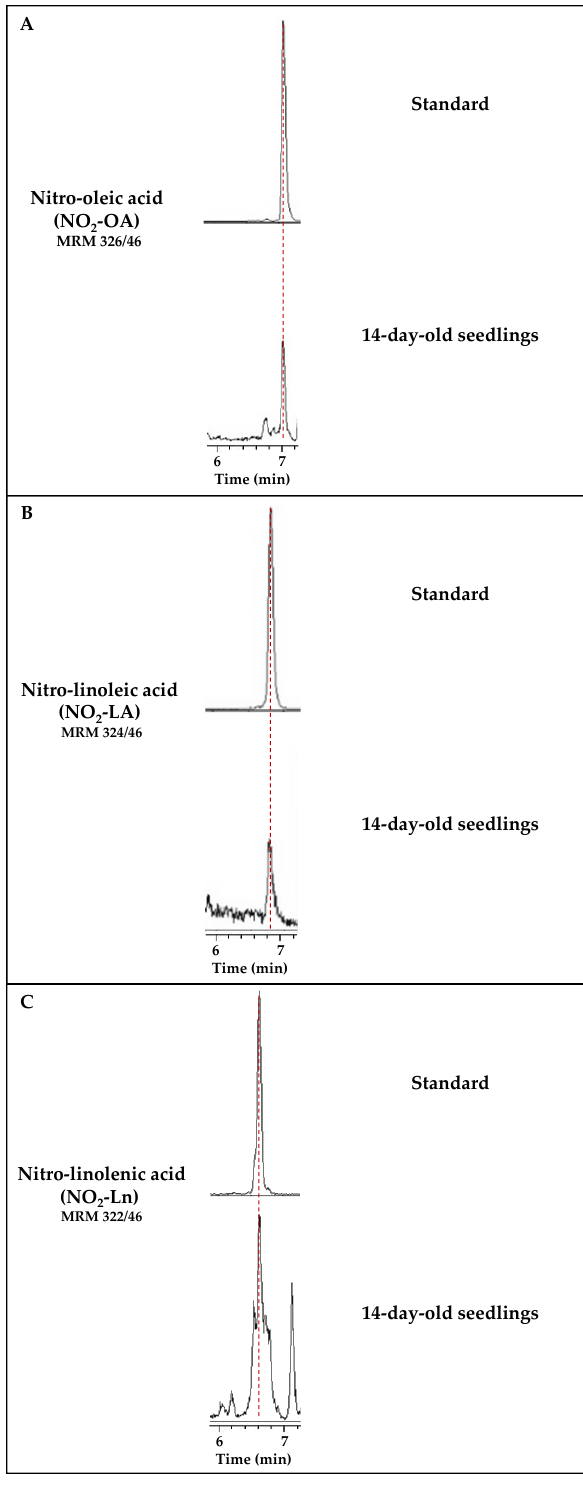
Figure 1. Detection of the main NO 2 -FAs present in Arabidopsis thaliana . Each panel shows the chromatogram corresponding to the standard of each nitrated fatty acid, NO 2 -OA ( A ), NO 2 -LA ( B ), and NO 2 -Ln ( C ). Their retention times coincide with the chromatographic peaks detected in the Arabidopsis lipid extracts from the 14-day-old seedlings. Peaks refer to a total ion intensity of 1.2 × 10 4 for the m / z transition of NO 2 -OA (326/46), 4 × 10 3 for NO 2 -LA ( m / z 324/46), and 1.4 × 10 4 for NO 2 -Ln ( m / z 322/46). The dotted vertical line indicates the peaks with the same retention